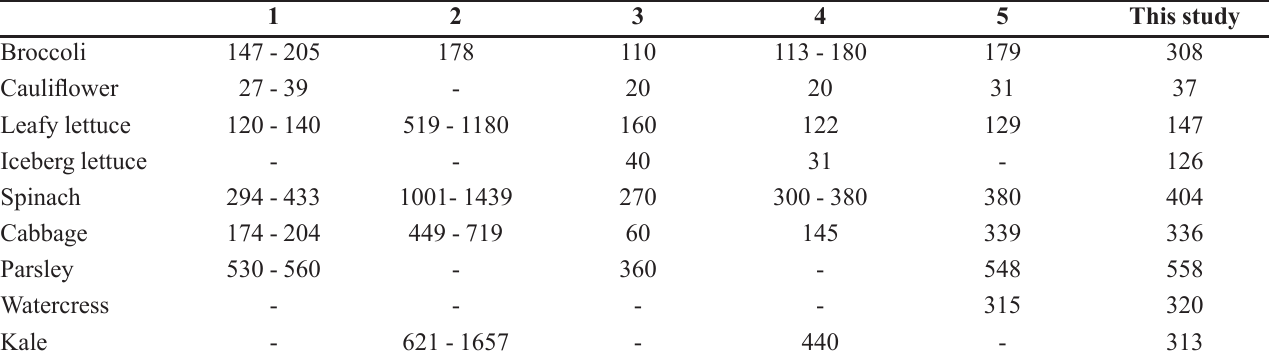
TABLE III – Comparison between different studies for phylloquinone content in vegetables (µg/100